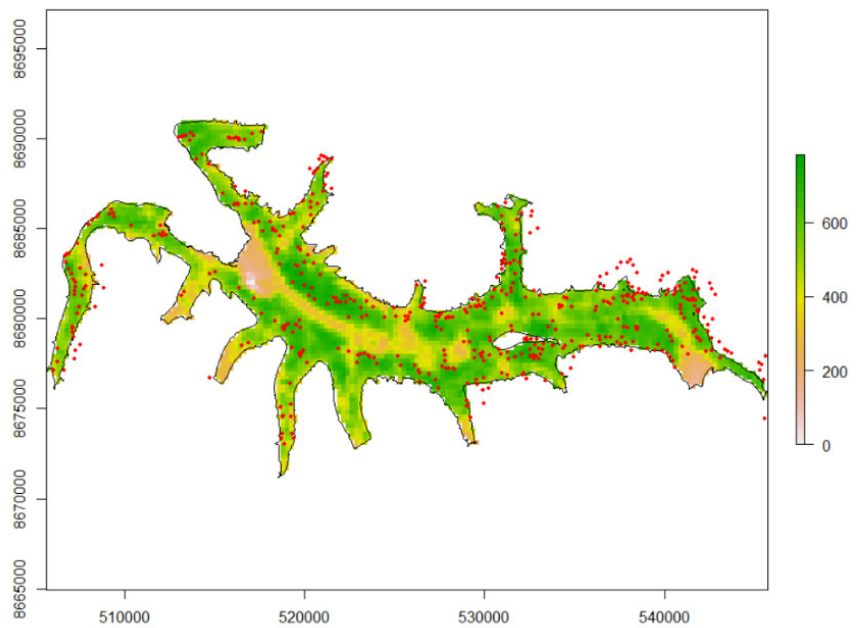
Figure A1. Reindeer geographic positions in the Sassendalen’s neighboring valley Adventdalen ( n = 1527). Table A1. Independent total counts density model obtained from ground counts in a neighboring valley. We used the most parsimonious density model for total counts from Le Moullec et al. [22], which modelled individuals per segment as a function of maxNDVI using a hurdle density model with a zero-truncated negative binomial distribution with a dispersion parameter. This model was fitted using the restricted maximum likelihood (REML) framework. The model presented below is the model with the highest AIC.